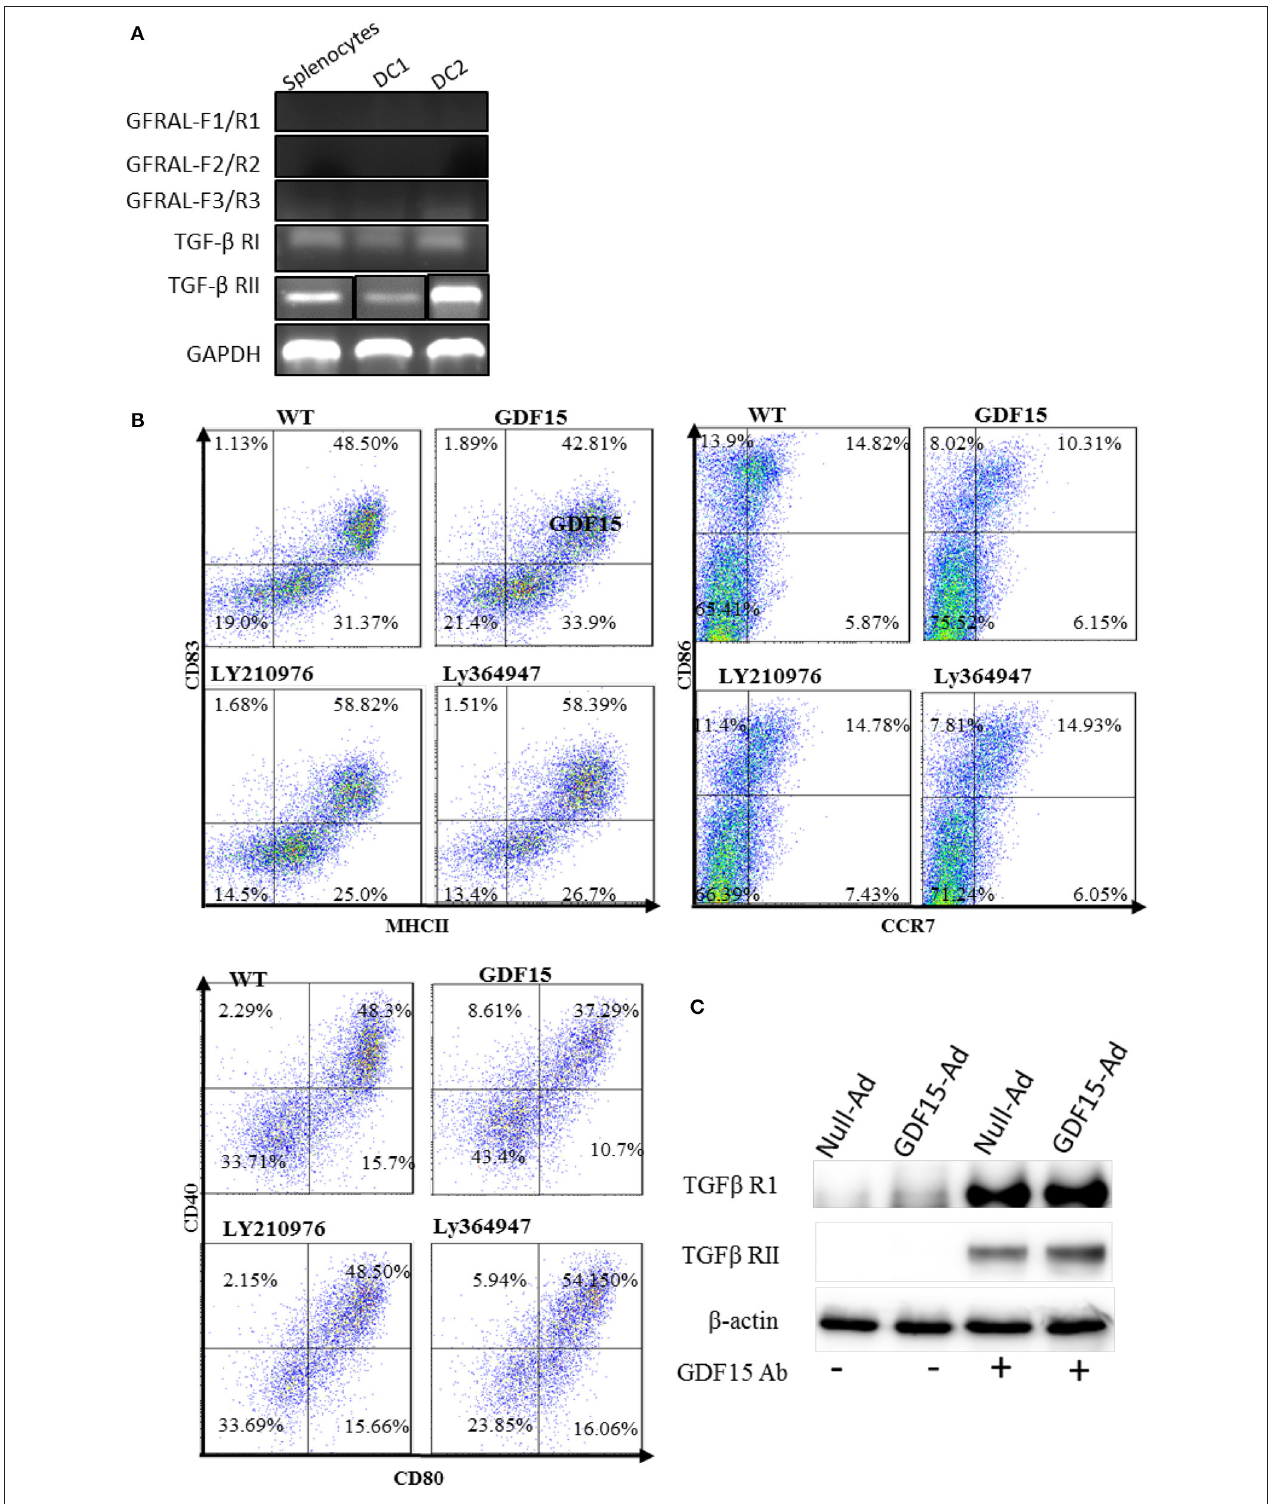
FIGURE 6 | GDF15 regulated DCs by using TGF β receptors. (A) Expression of GFRAL and TGF- β RI and RII. RNA was extracted from DCs and the expression of GFRAL and TGF- β RI and RII was detected by RT-PCR. PCR products were run on 1.5% agarose gel and visualized with EB. (B) TGF- β receptor I and II reversed the inhibitory function of GDF15 in DC maturation. DCs cultured from WT mice and treated with rhGDF15 on day 4. Ly210976 (5 mg/ml) and Ly 364947 (10 mg/ml) was